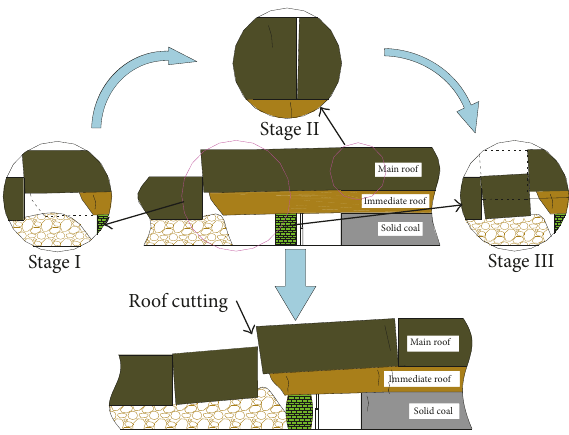
Figure 2: Structural characteristics of the GER roof by the caving